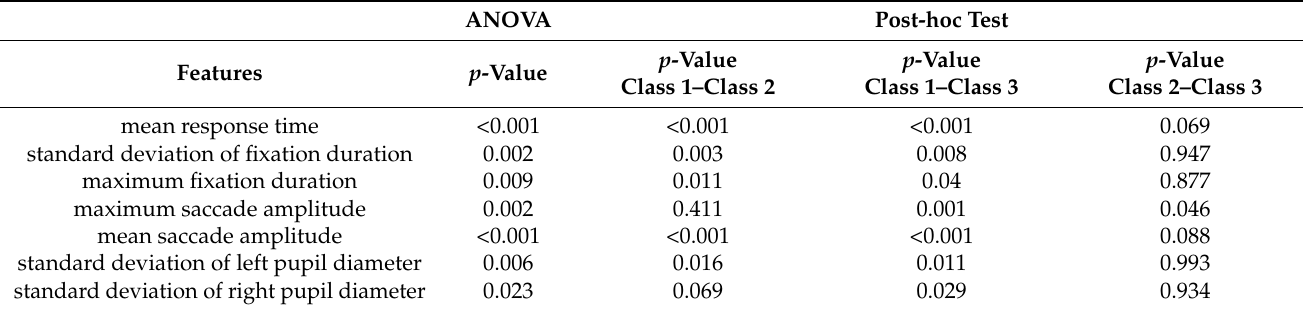
Table 8. The results of one-way ANOVA analysis.